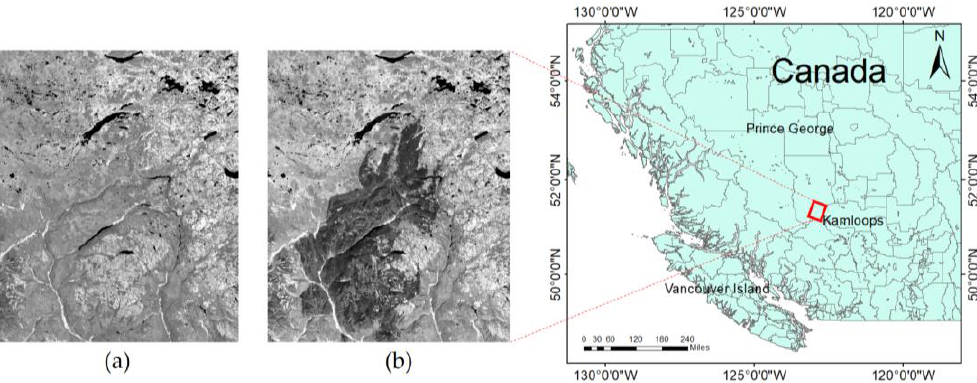
Figure 7. Canada dataset. ( a ) Image acquired on 2 July 2017. ( b ) Image acquired on 22 August 2017.